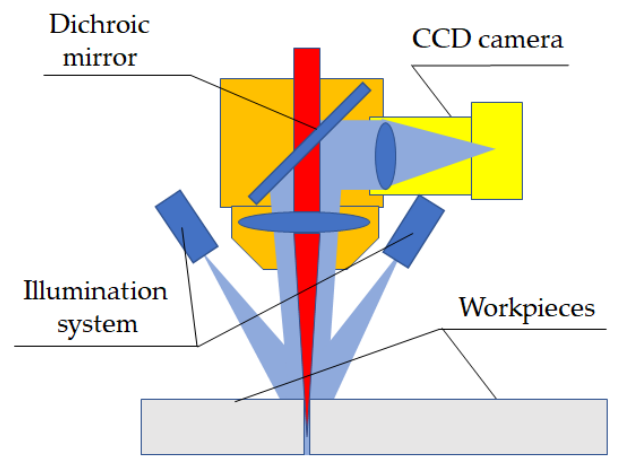
Figure 2. Scheme of the LRC-W tool.